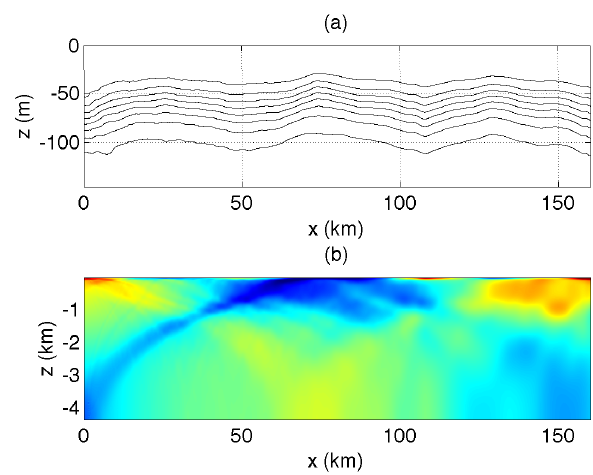
Fig. 10. Caption as for Fig. 4, this time for E3. The two dashed, red lines are now separated by 55km and correspond to velocities of 1 . 23 m . s − 1 (namely, 55km per M2 period). The large displacement located between 40 and 55km corresponds to the ITB impact on the thermocline.